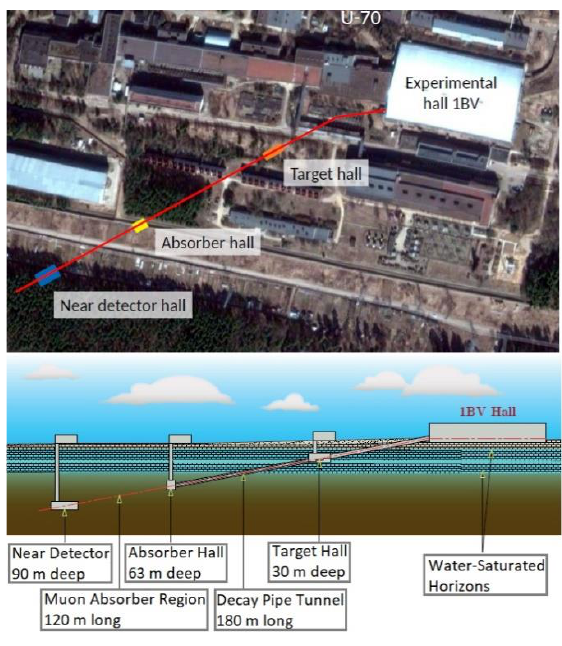
Figure 3. Top view and elevation view of the neutrino channel.